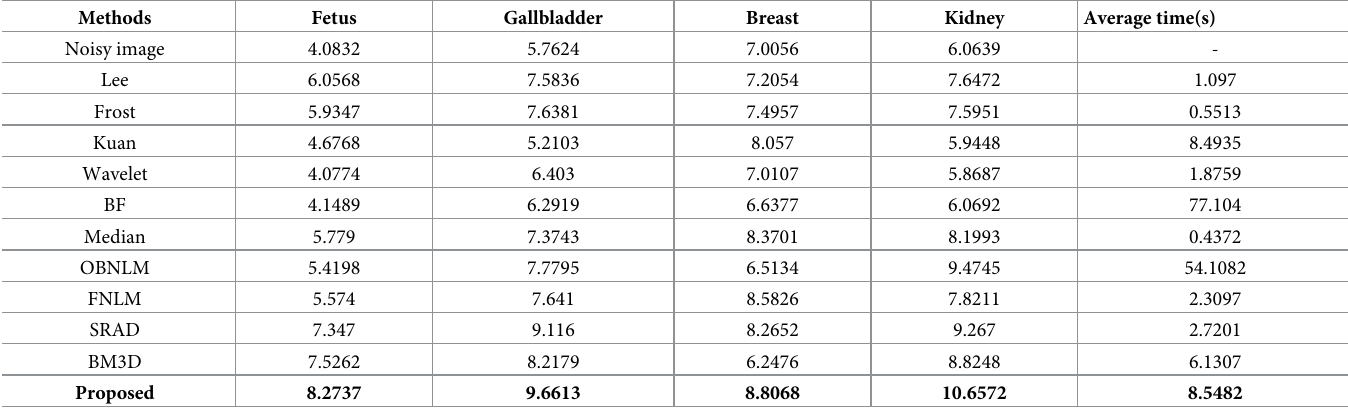
Table 3. NIQE values and average execution time in the four organs images using different methods.